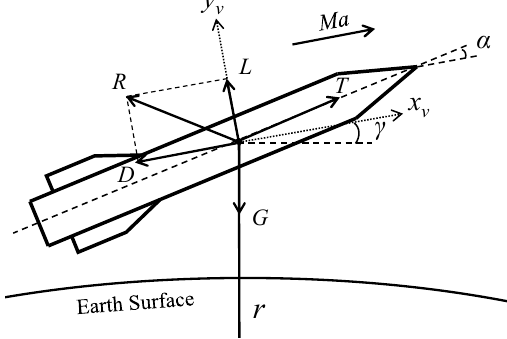
Figure 1. Force analysis diagram of aircraft.